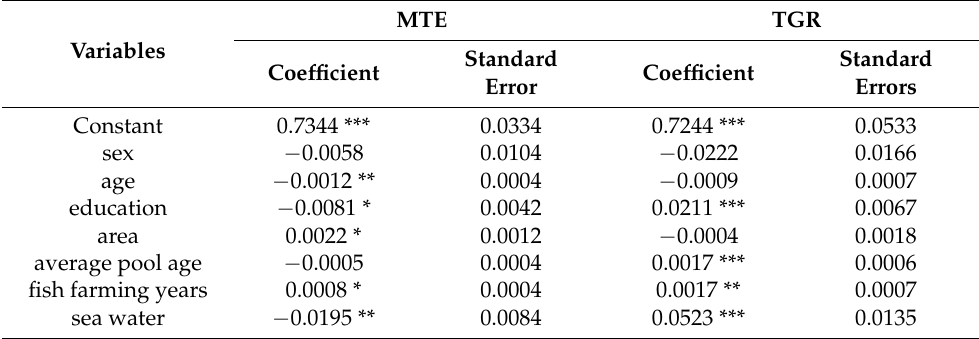
Table 4. Regression results on the metafrontier technical efficiency (MTE) and technical gap rate